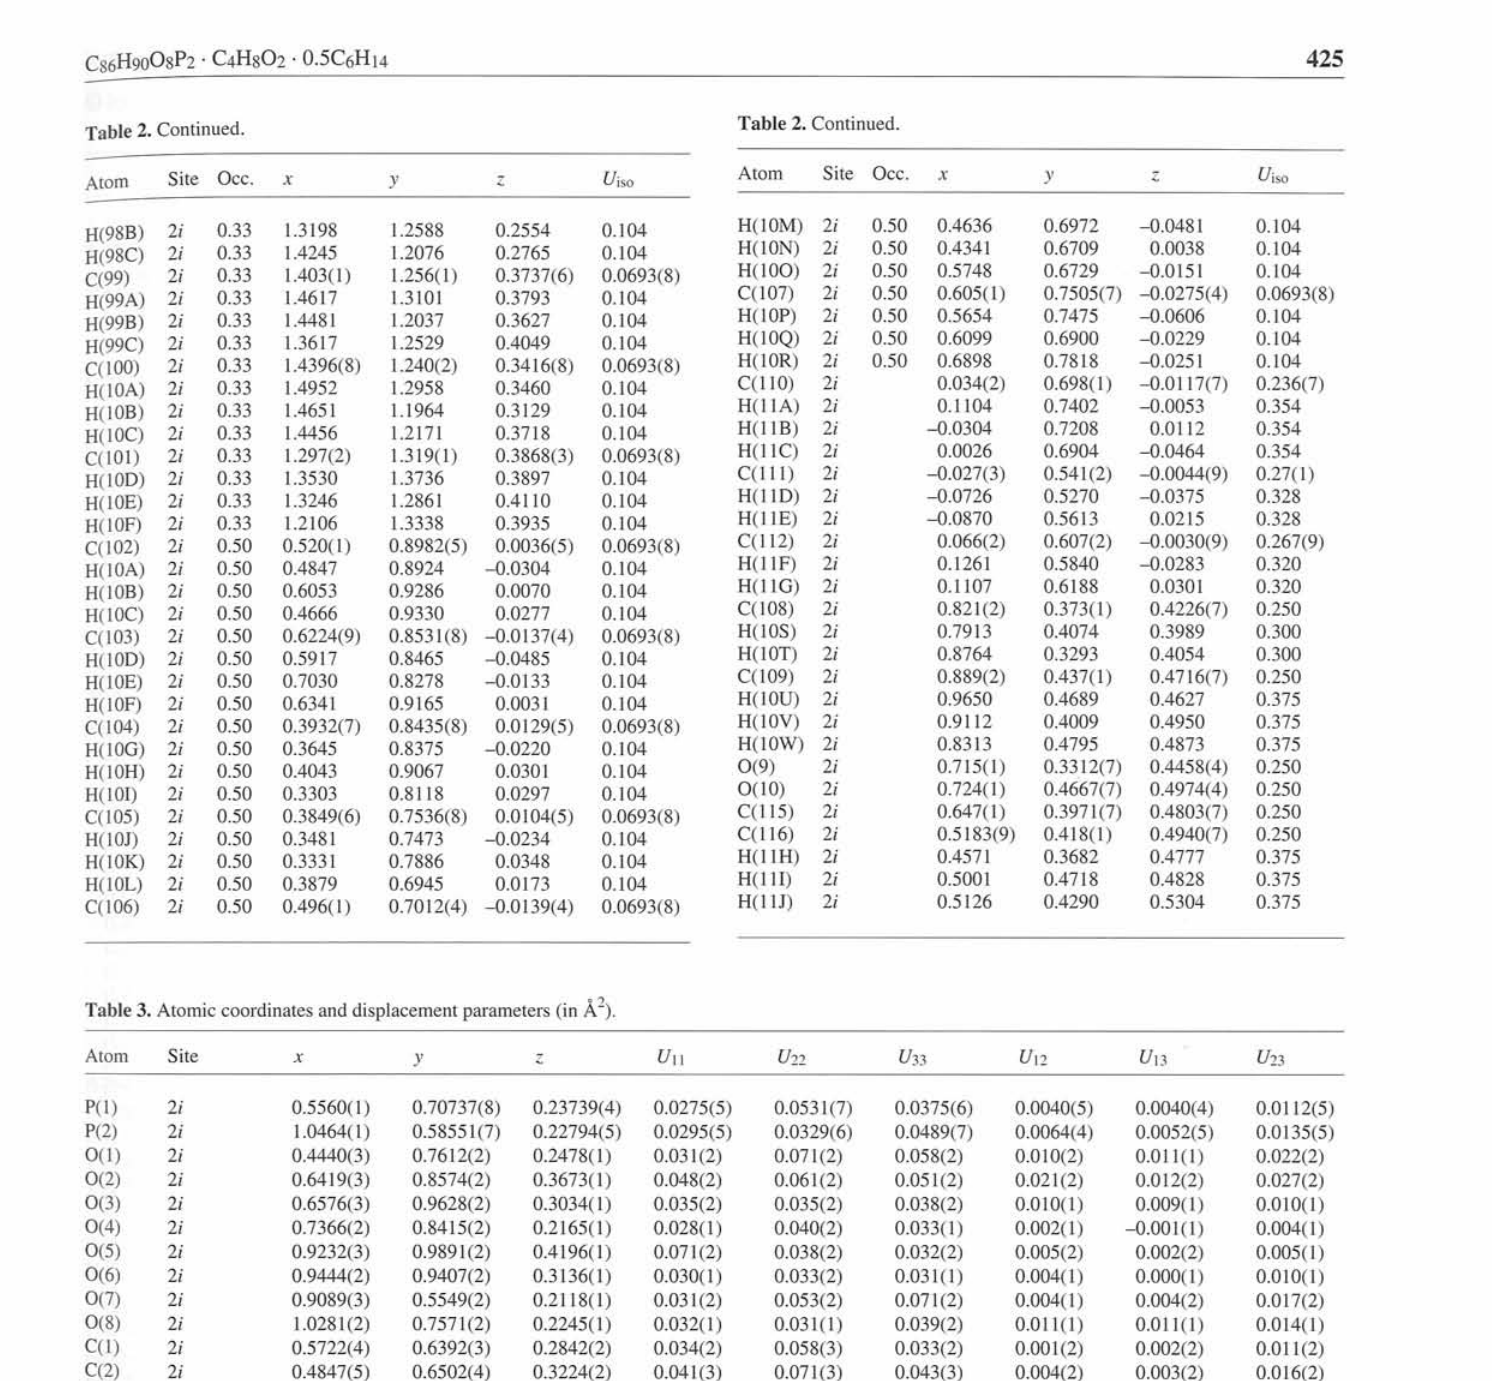
Table 3. Atomic coordinates and displacement parameters (in Atom